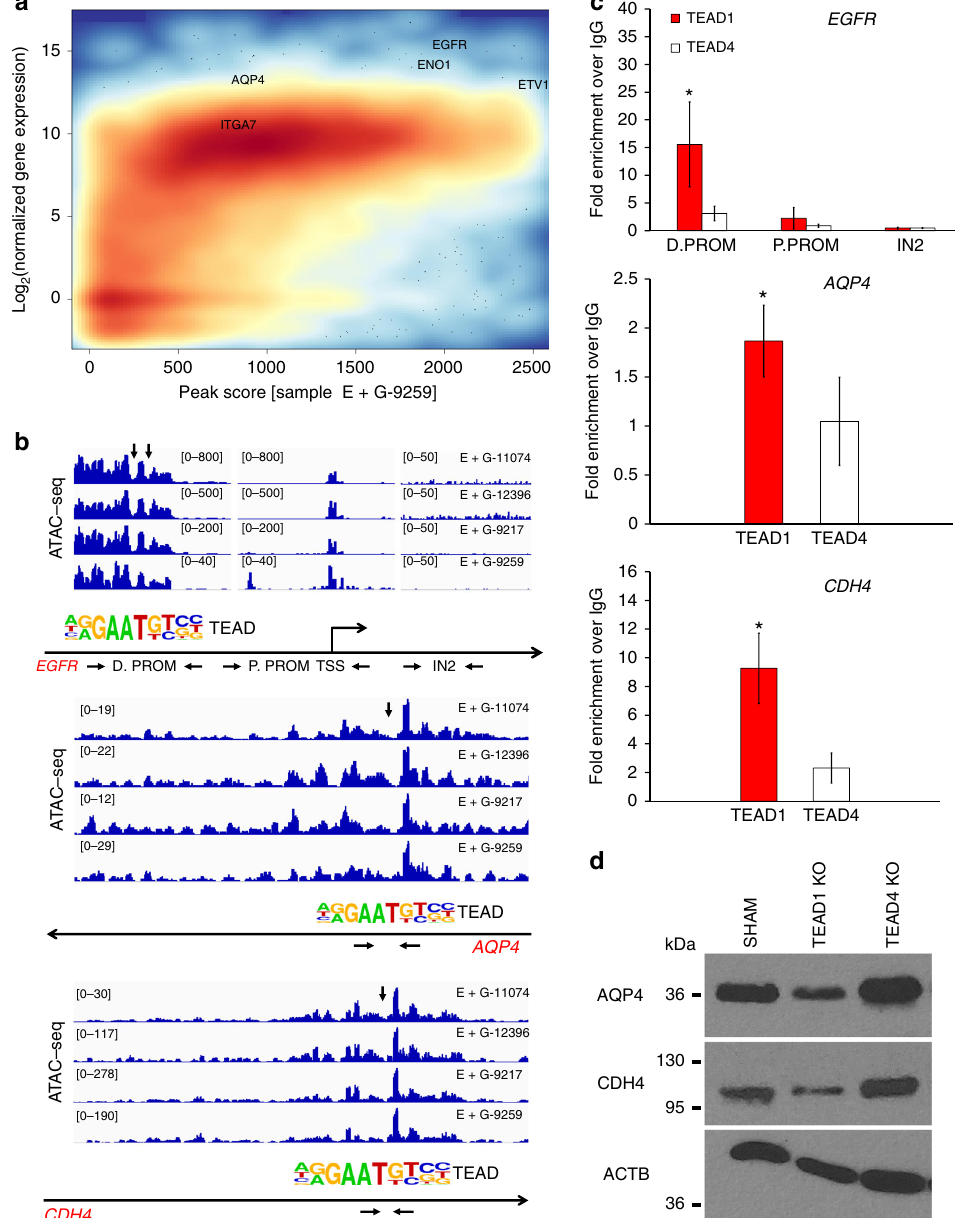
Fig. 5 Validation of TEAD1-binding targets by chromatin immunoprecipitation. a Density plot of correspondence analysis between chromatin accessibility and gene expression. Plotted on the y -axis is the average rld-normalized gene expression for each gene from all RNA-seq E + GSC sample data. Plotted on the x -axis is the highest ATAC-seq peak associated with the proximal promoter [ − 5 kb, + 3 kb] of the same gene. Color intensity indicates density of the gene population, with red representing higher densities and blue representing lower densities. Strong correspondence is observed between open chromatin peaks and a moderate/high level of gene expression in all E + GSC samples (plot for one representative sample shown here). Several putative TEAD1-target genes of interest are indicated on the plot. b IGV plot of ATAC-seq piled reads at EGFR , AQP4 , and CDH4 in four different acutely sorted E + GSCs (D.PROM distal promoter of EGFR, peak180759: chr7:55,000,372 – 55,001,595; P.PROM proximal promoter to TSS of EGFR, peak180777: chr7:55,085,981 – 55,088,747). For this IGV representation, reads are centered on the cut site of the Tn5 enzyme, correcting for the 9 bp occupancy of Tn5, and presumed footprints/peak troughs corresponding to TEAD motifs are delineated by downward arrow. c Chromatin immunoprecipitation (ChIP-PCR) in GBM tissues. Signi fi cant enrichment of TEAD1 (but not TEAD4) over IgG is seen speci fi cally at differential open chromatin peaks with associated TEAD1 motif within the upstream promoter of EGFR (D. PROM, chr7:55001141 motif start site) ( n = 6, * p = 0.011), at CDH4 (chr20:60011935 motif start site) ( n = 6, * p = 0.027), and at the proximal promoter of AQP4 (chr18:24444251 motif start site) ( n = 6, * p = 0.029). Signi fi cant binding above background is not observed at EGFR P.PROM or at chromatin inaccessible regions (IN2 = EGFR intron 2). Enrichment is expressed as fold increase over IgG, after normalization with 10% input, using 2^ – ΔΔ Ct analysis accounting for primer ef fi ciency: ( E ^IA − S ) sample /( E ^IA − S ) IgG . E : primer ef fi ciency; IA: 10% Input-Adjusted Ct; S : sample Ct. Bars represent mean ± SEM. d Western immunoblot illustrates decreased expression of AQP4 and CDH4 in TEAD1KO but not in TEAD4KO G-13063 GBM